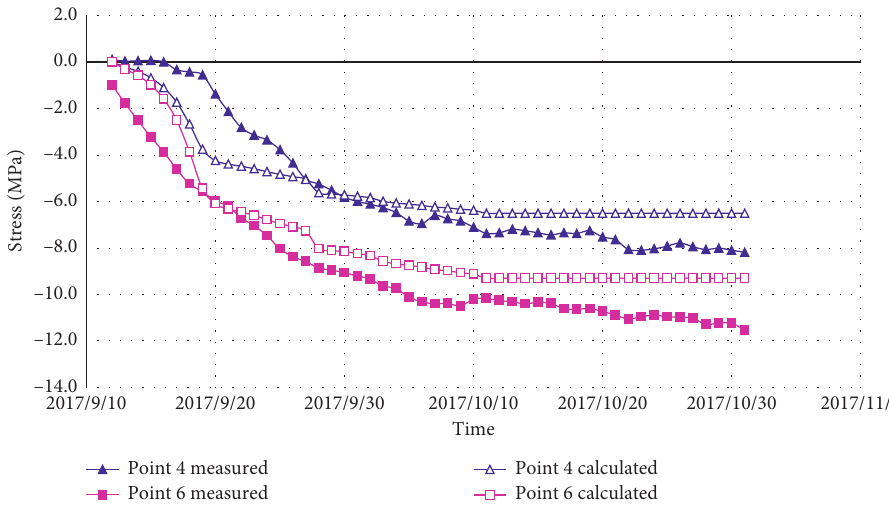
Figure 15: Stress simulation and measurement of measuring points 4 and 6 on the eastern